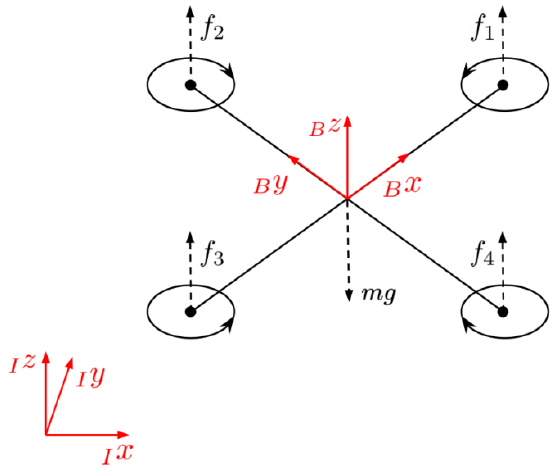
Figure 6. Inertial and body-fixed reference systems.